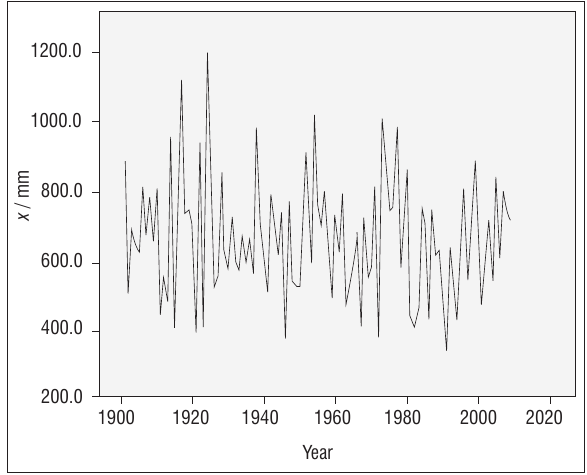
mean annual rainfall for Zimbabwe i